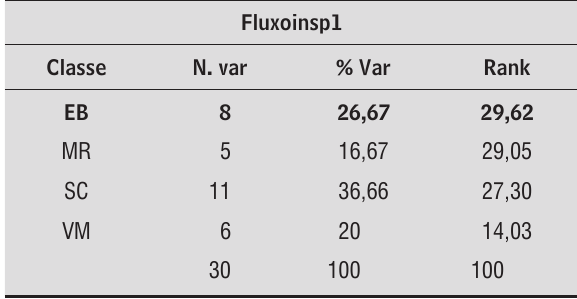
Fonte: Dados da pesquisa.